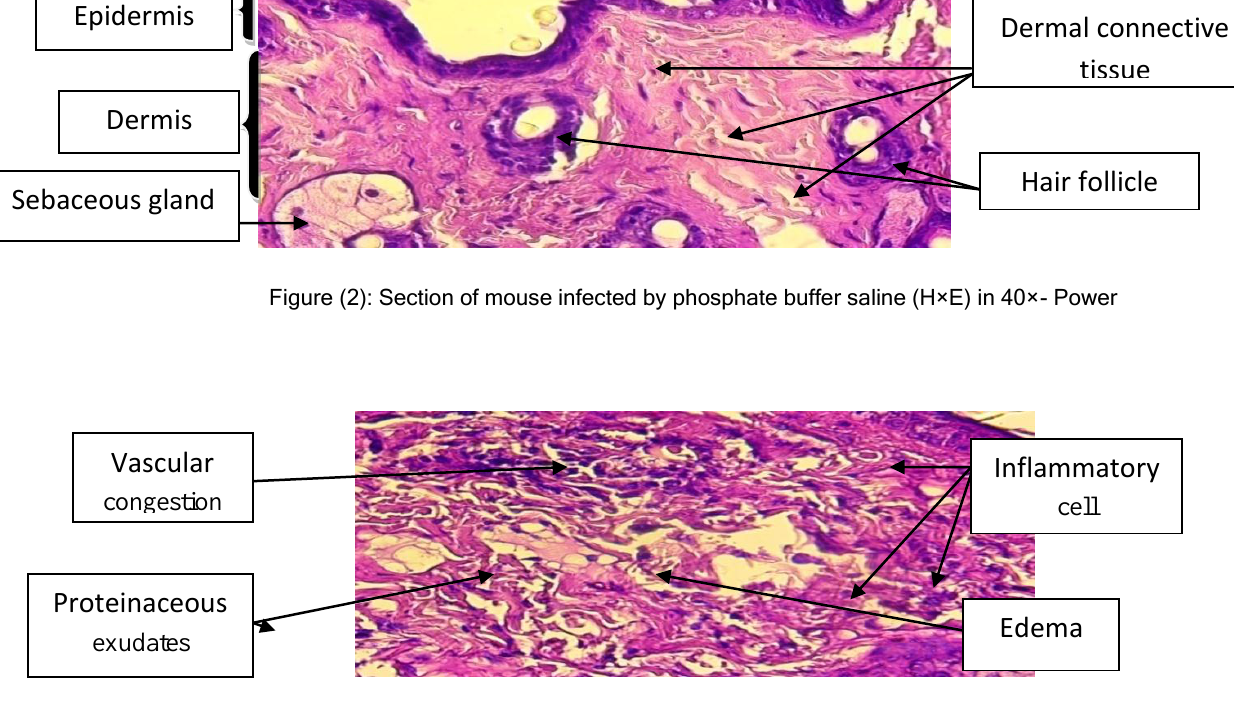
Figure (3): Section of mouse infected by S. aureus without treatment (H×E) in 40× Power